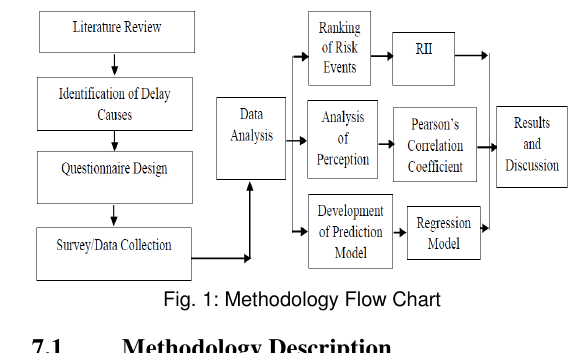
Fig. 1: Methodology Flow